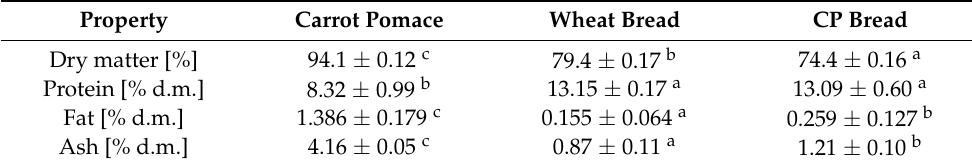
Table 3. Basic characteristics of the carrot pomace and bread. Property Carrot Pomace Wheat Bread